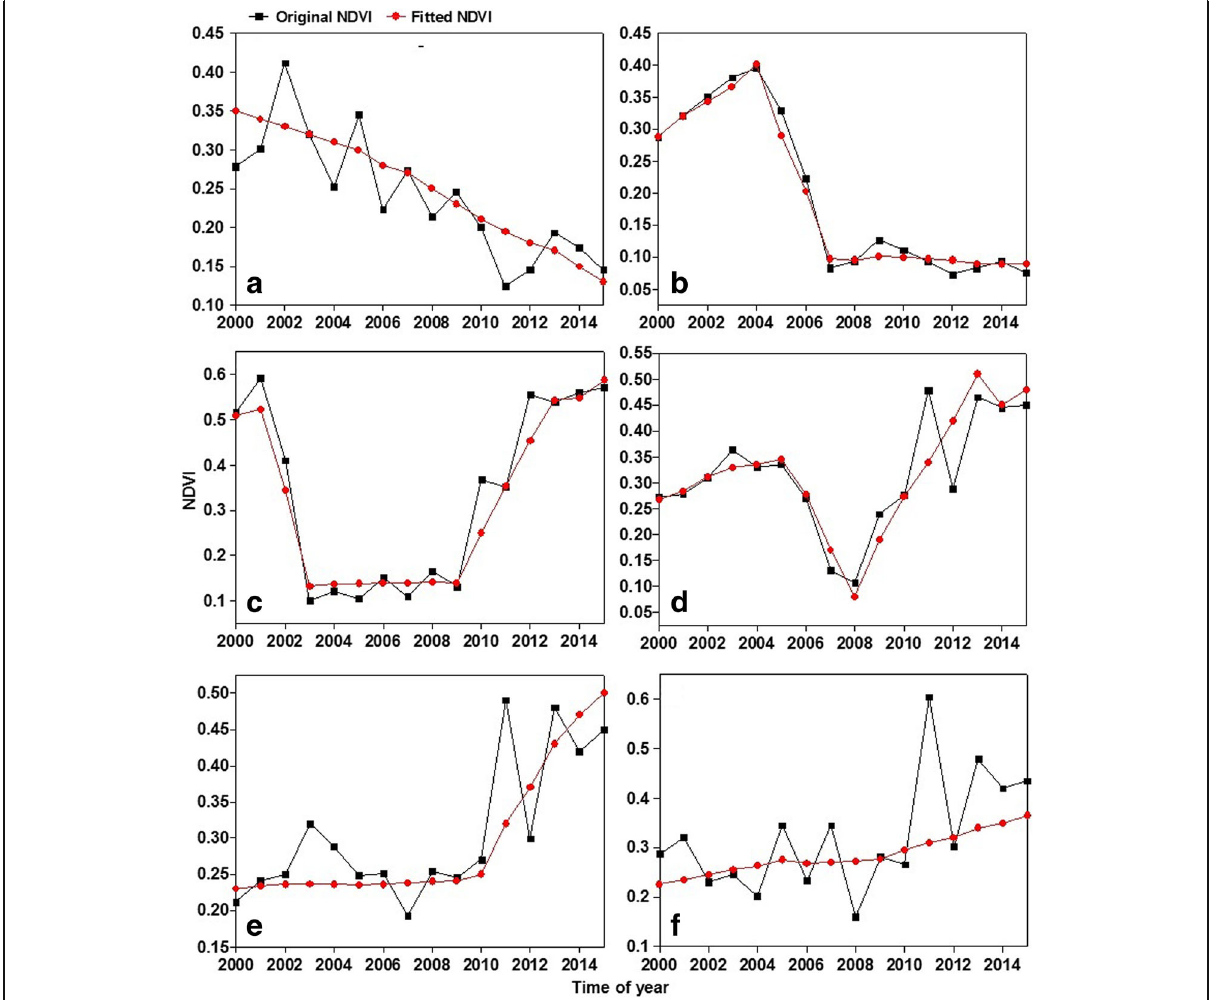
Fig. 3 Time spectrum curves of vegetation dynamic types. ( a ) Continuous disturbance. ( b ) Disturbance-stabilization. ( c ) Disturbance-stabilization- recovery. ( d ) Disturbance-recovery. ( e ) Stabilization-recovery. ( f ) Continuous